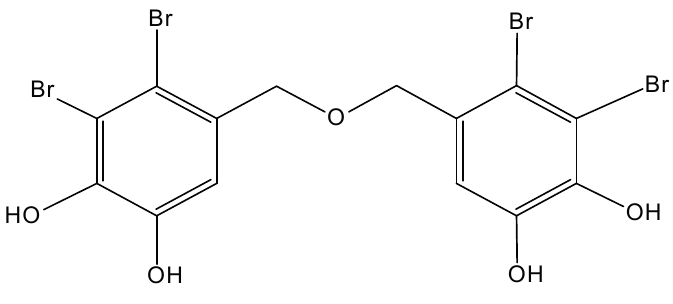
Figure 24. Bis (2,3-dibromo-4,5-dihydroxybenzyl) ether (BBDE, 62